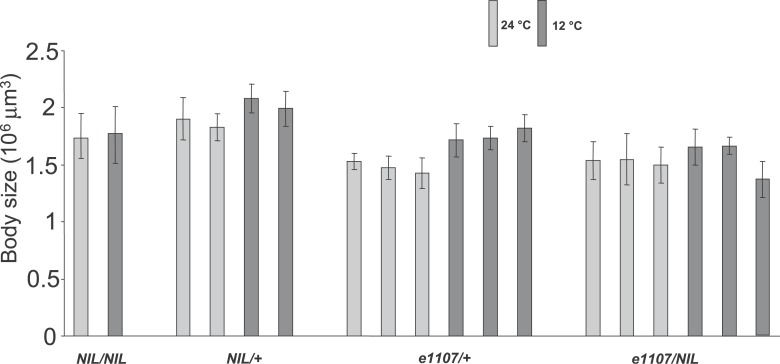
Complementation Analysis: The Effect of Temperature on Body Size in C. elegans Strains and MutantsTo test for complementation of F96L we measured body size of the homozygous introgression line NIL WN17–9 (abbreviated as NIL/NIL) and heterozygote F
1 obtained from the complementation crosses. Two independent crosses between NIL and N2 (NIL/+) revealed complementation. Complementation was revealed in three independent crosses of tra-3(e1107)/+, whereas three other independent crosses of the heteroallele tra-3(e1107)/NIL revealed no complementation. Bars are standard deviation. Significance testing was performed using nested analysis of variance (see Materials and Methods). NIL/NIL:F
(1,51) = 1.54, NIL/+:F
(1,2) = 21.94*, e1107/+:F
(1,4) = 59.28**, e1107/NIL:F
(1,4) = 4.00, and (* = 0.01 < p
< 0.05, ** = 0.001 < p
< 0.01).